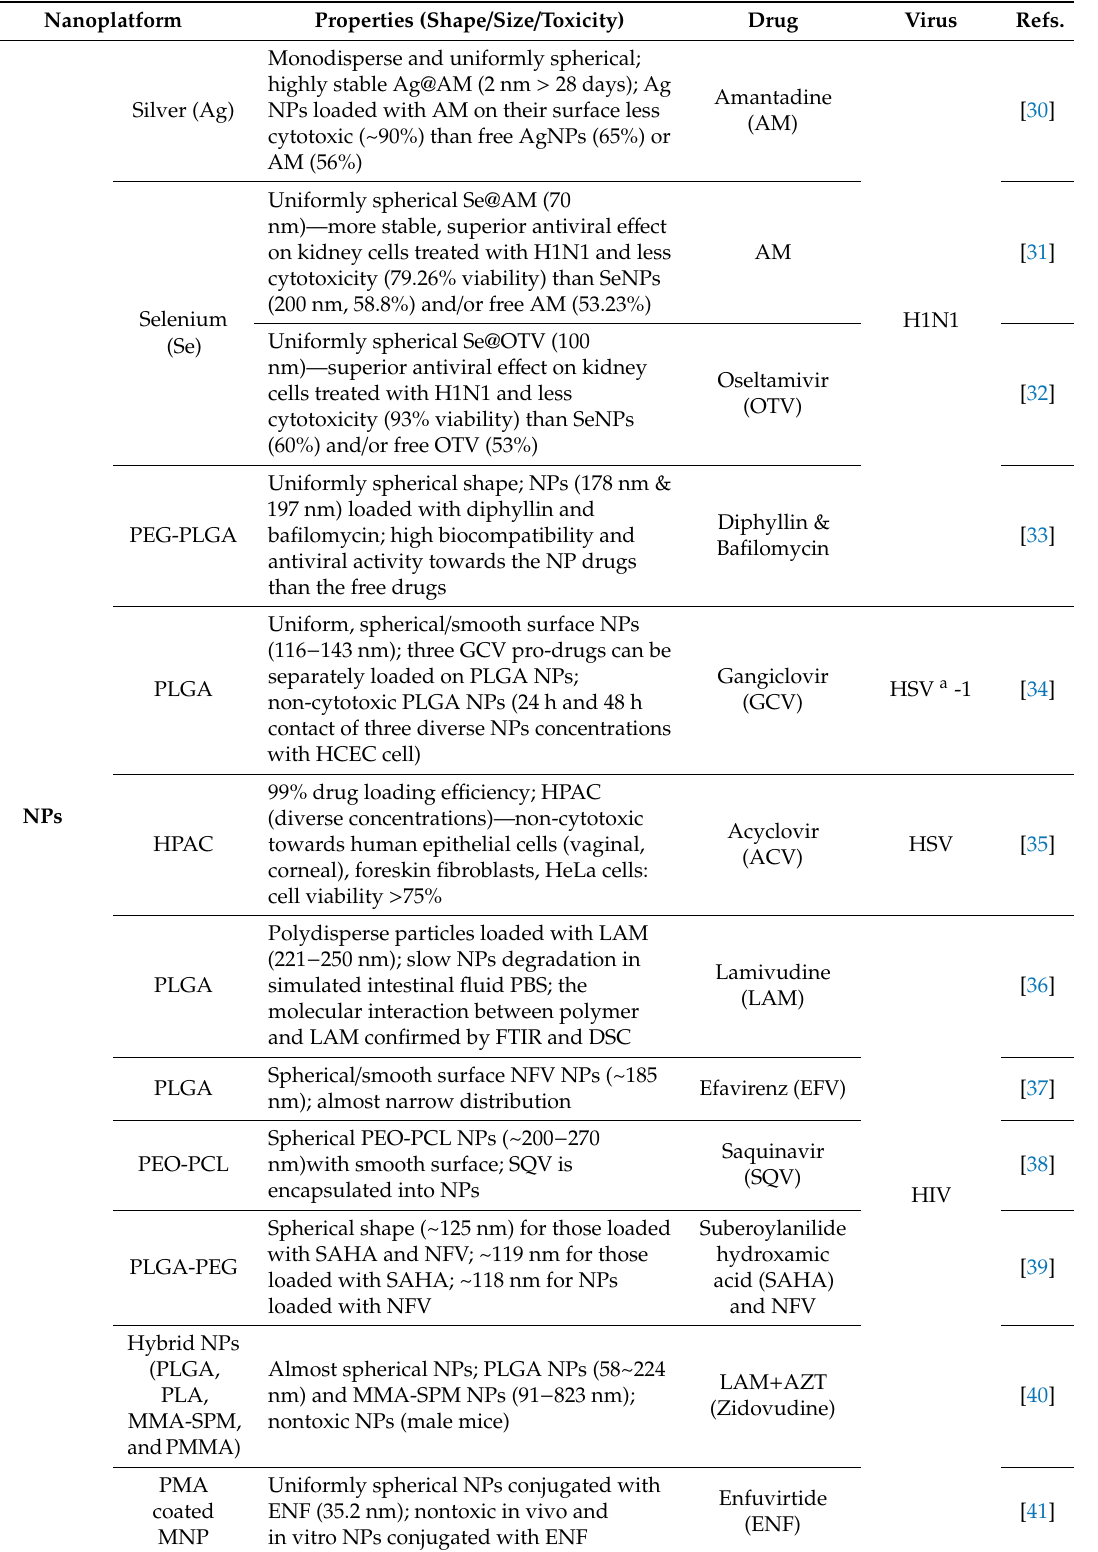
Table 1. Summary of developed nanoparticulate drug delivery systems towards treatment and / or therapy of viral infections.